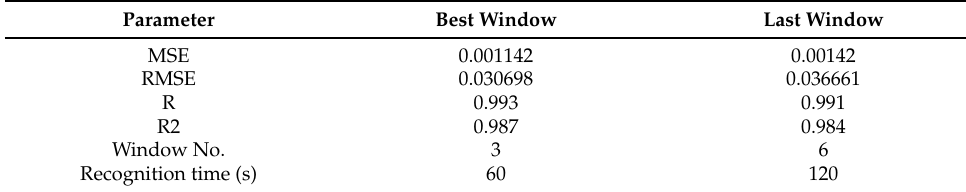
Table 7. Summary of performance of ANN-R algorithm.